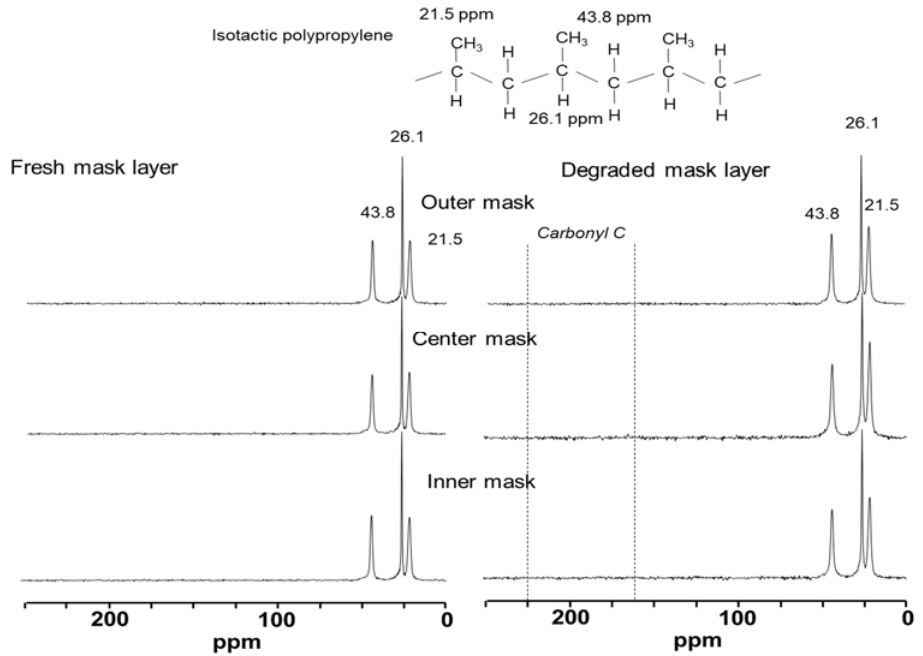
Figure 3. Representative solid-state CPMAS 13 C NMR spectra of the different layers of a 3-layered polypropylene-based surgical face mask before and after 6 months of microbial degradation in the topsoil of a Cambisol with a moisture of 75% of the maximal water holding capacity. The chemical shifts of the different resonance lines are indicated by numbers above the signal. Their intensities are listed in Table 1 as the mean of three NMR measurements of three sample replicates together with their standard deviations.